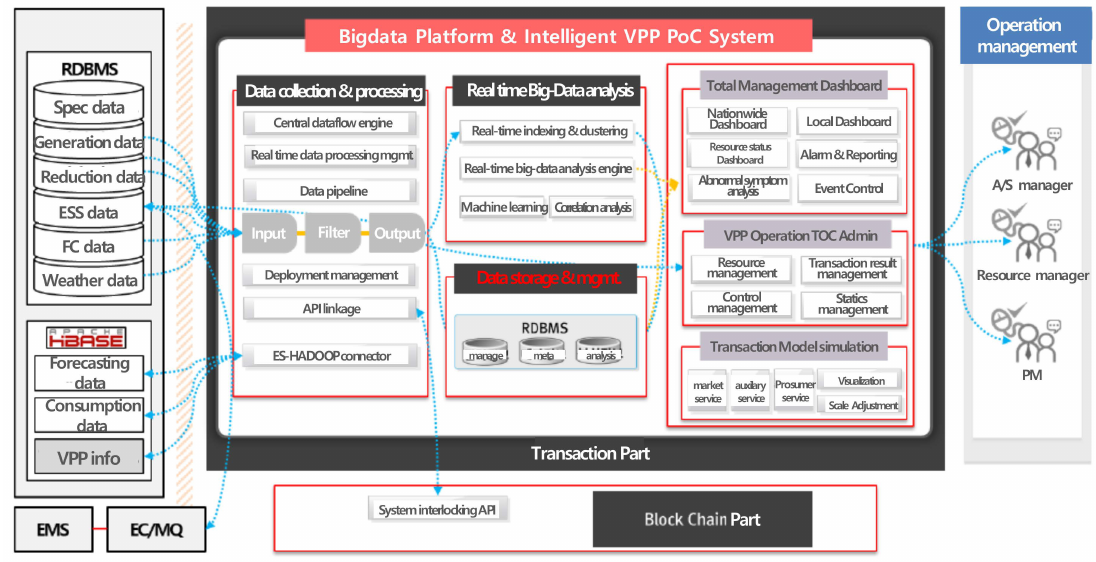
Figure 14. Architecture of VPP PoC in the KT-MEG.